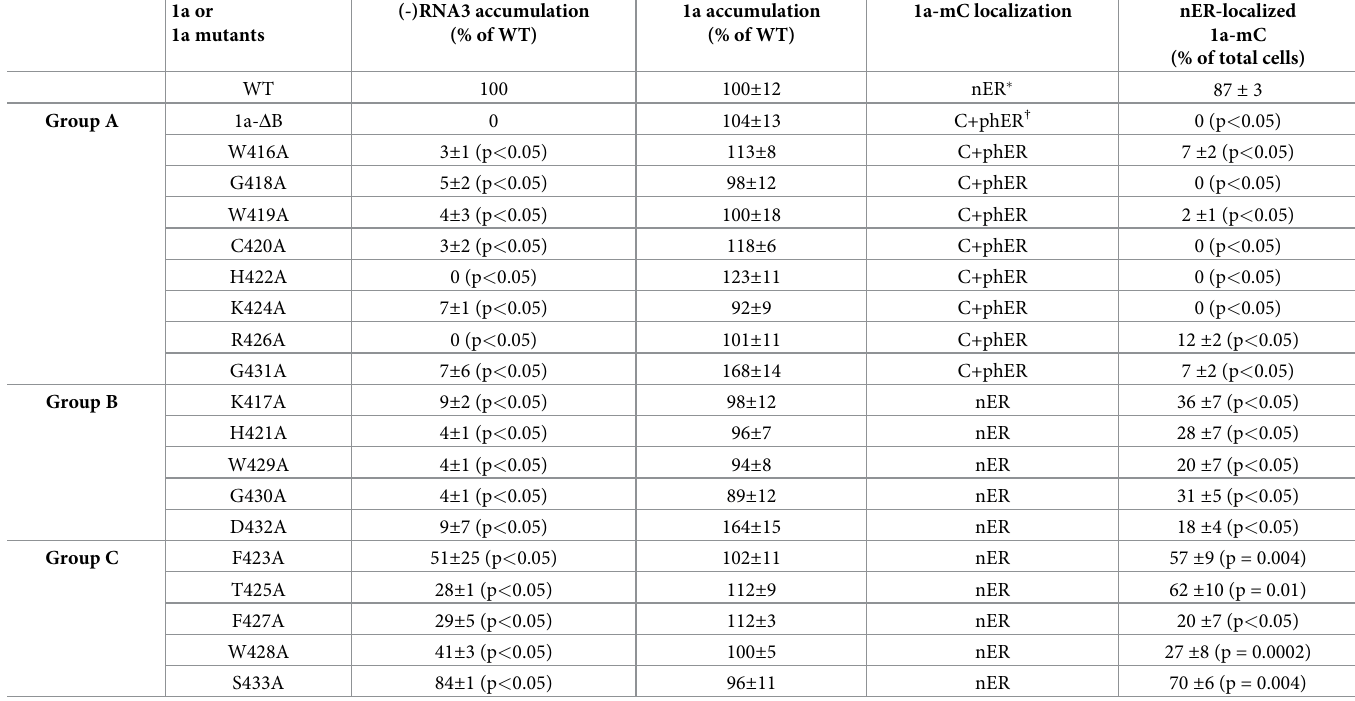
Table 1. Characteristics of 1a helix B mutants. 1a or 1a